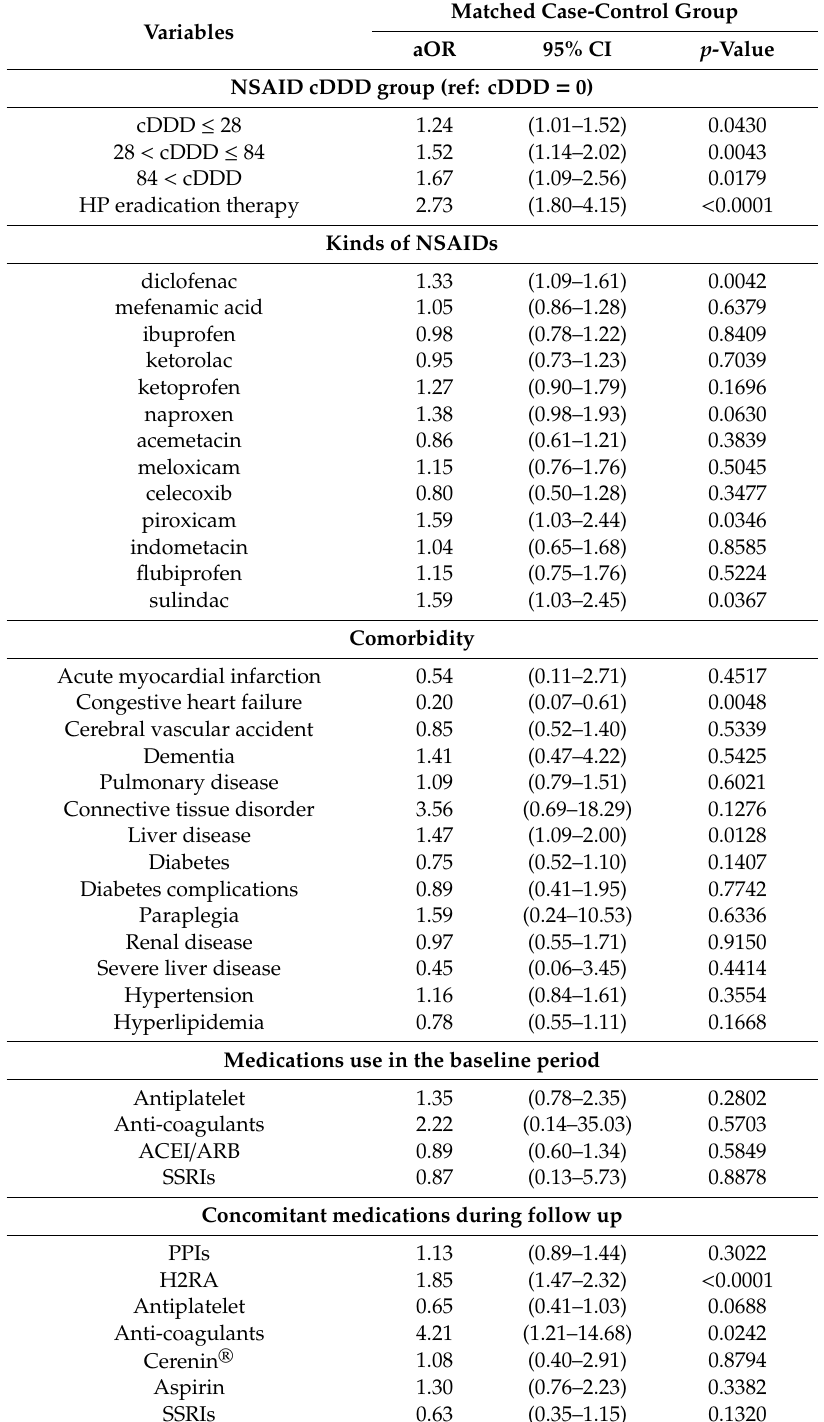
Table 2. Factors associated with recurrent PUD occurrence in matched case-control